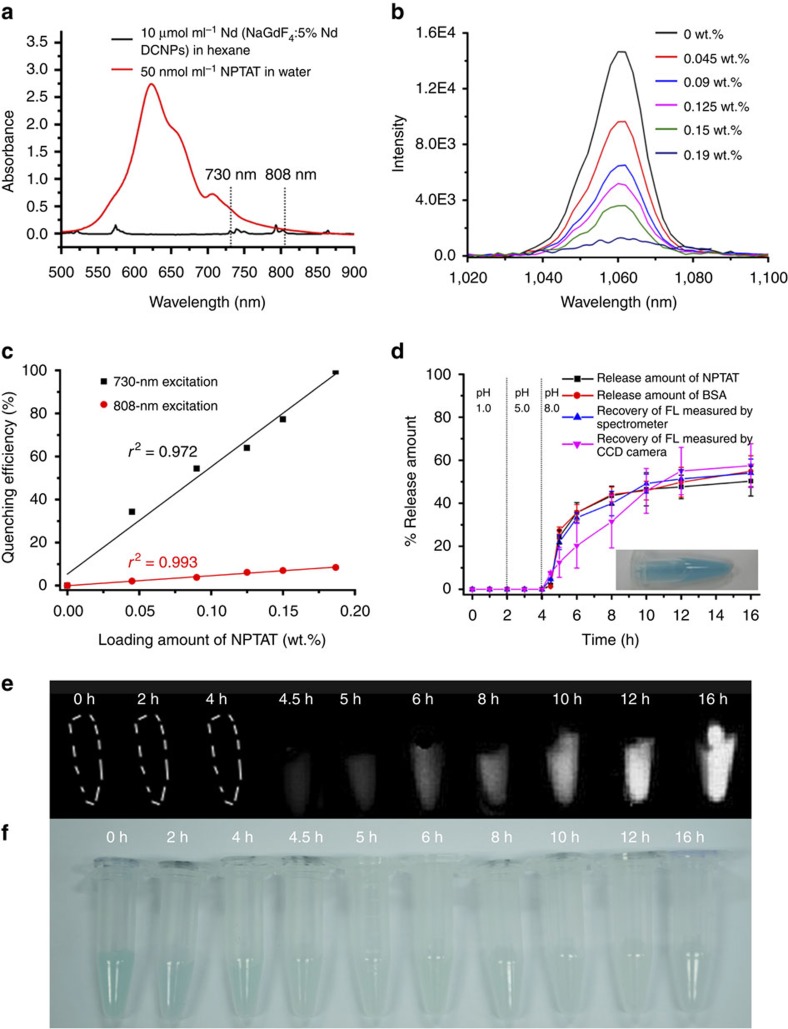
Feasibility investigation of the ACIE method for in vitro drug-release monitoring.(a) Absorption spectra of 10 μmol ml−1 DCNPs dispersed in hexane and 50 nmol ml−1 NPTAT dispersed in water. It should be noted that the concentration of the DCNPs was determined from the Nd element content in the solvent. (b) NIR FL signals as a function of the NPTAT loading amounts in the microcarrier under 730-nm excitation. (c) NIR FL intensity of microcarriers loaded with different amounts of NPTAT under 730- or 808-nm excitation, respectively. (d) Time-dependent release profiles of BSA–NPTAT-loaded microcarriers in simulated GI tract fluids. Inset shows the optical graph of the NPTAT-loaded microcarriers (mean±s.d. for n=3). (e,f) NIR FL and optical images of microcarriers at different release time points. Representative images are for n=3 per group.